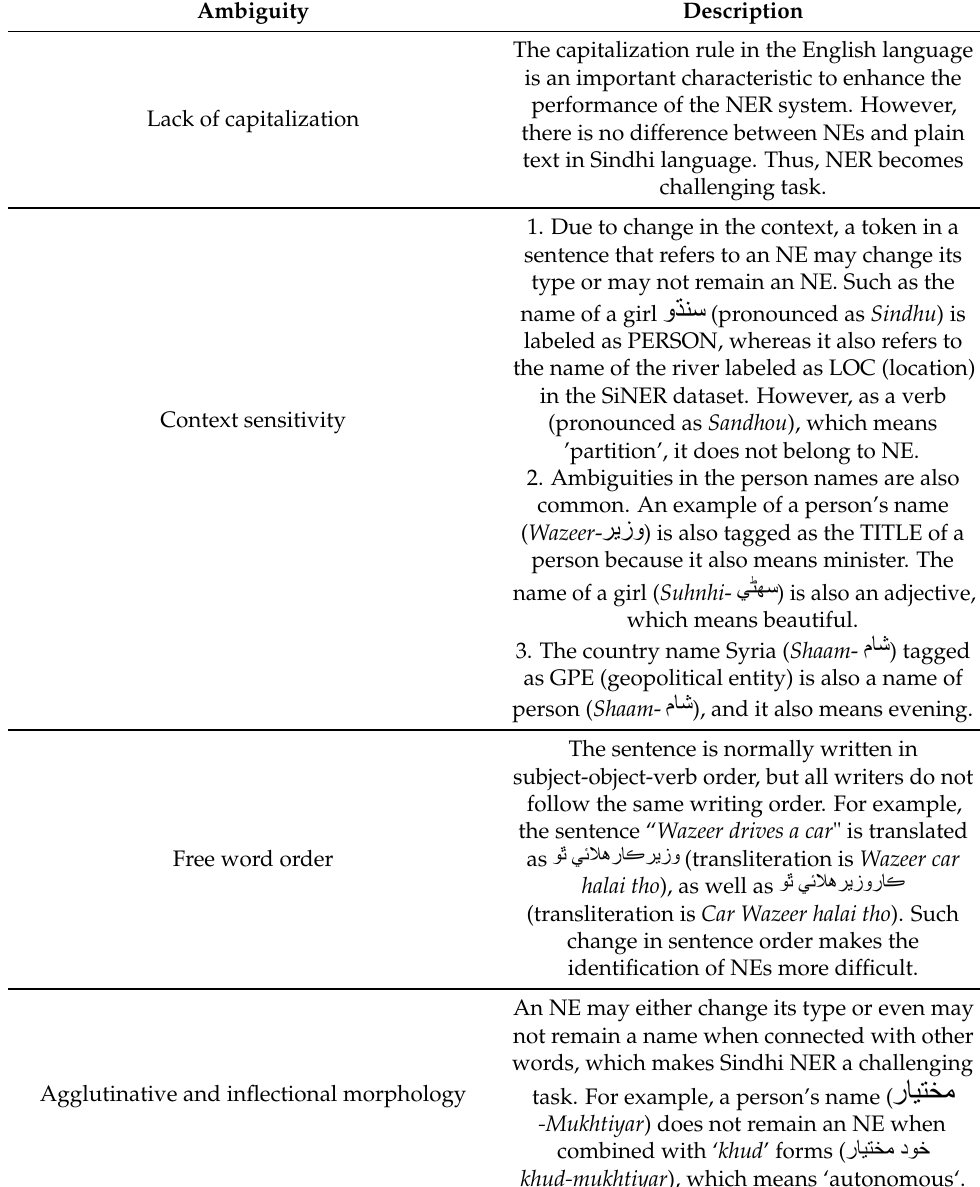
Table 1. A list of the ambiguities related to Sindhi NER, along with